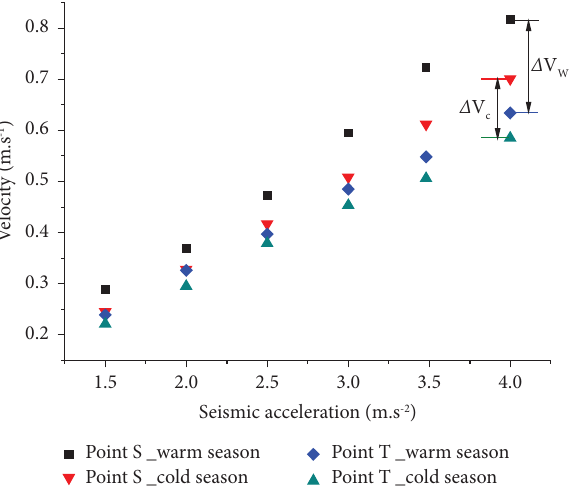
Figure 9: Te variation of maximum velocity with the input ground motion acceleration